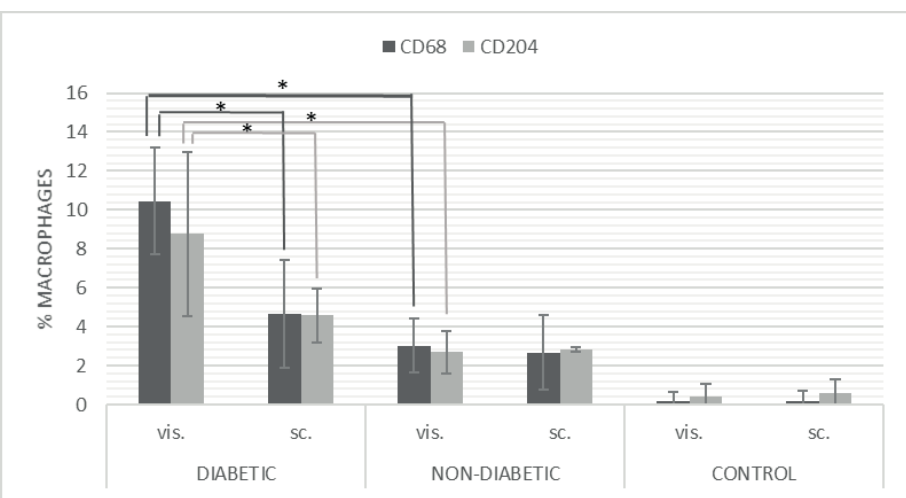
Fig. 4. Number of CD68+ and CD204+ of macrophages in control, diabetic patients and T2D patients. Statistically significant differences are marked with